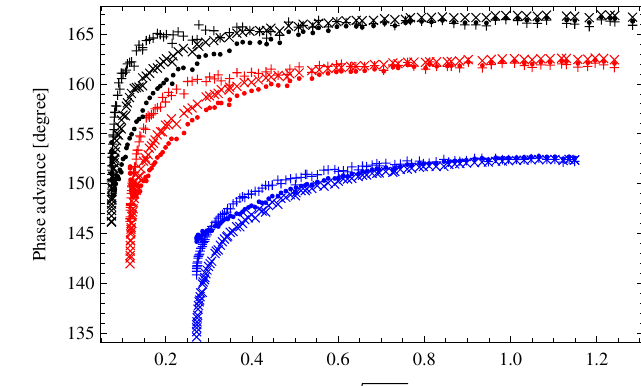
FIG. 11. Phase advances needed for dispersion matching from AME ( (cid:2) ), TME ( þ ), and EME ( (cid:7) ) dipoles to the TME dipole under different peak fields 2 (blue), 4 (red), and 6 (black). Phase advances for uniform dipoles are 128 (cid:6) , 133 (cid:6) , and 133 (cid:6) ,